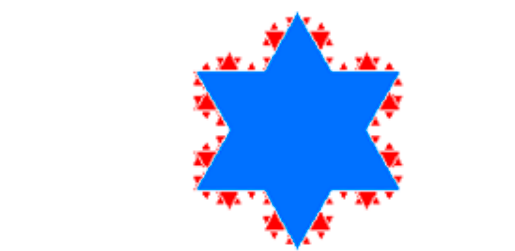
Figure 9. (Color online) The first iteration of the simplification process of the Koch snowflake guided by area (note: Red triangles are the tail part that needs to be eliminated at the first level).